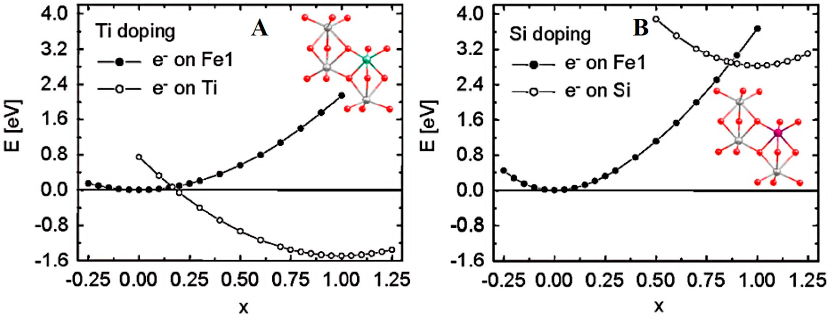
Figure 7. Unrestricted Hartree-Fock (UHF) potential energy curves along the nuclear reaction coordinates for electron transfer between Fe1 and ( A ) Ti with Ti doping ( B ) Si with Si doping. The hollow and solid circles represent actual calculation data points. The energy for x = 0 on the left curve is set to zero. Adapted with permission from [82]. Copyright 2011 American Chemical Society.